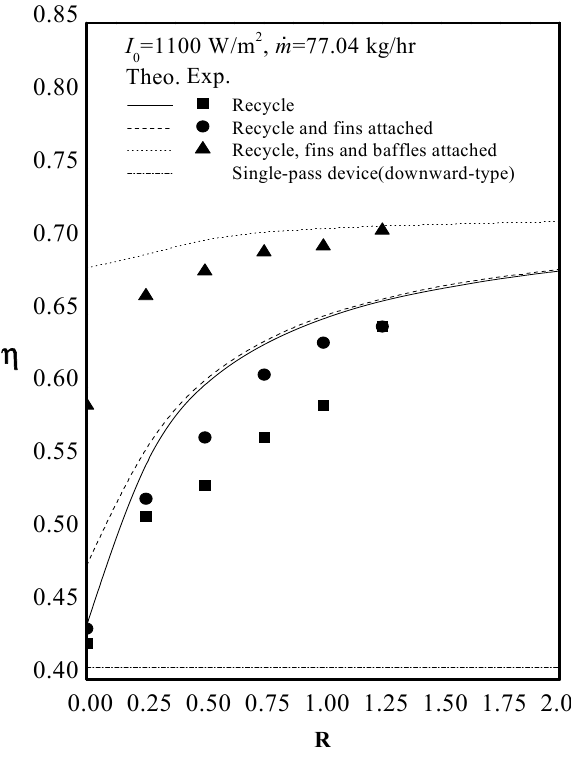
Figure 9. Effect of recycle ratio on collector efficiency in a double-pass flat-plate solar air heater with recycle; I = 1100 W/m 2 , m  = 77.04 0